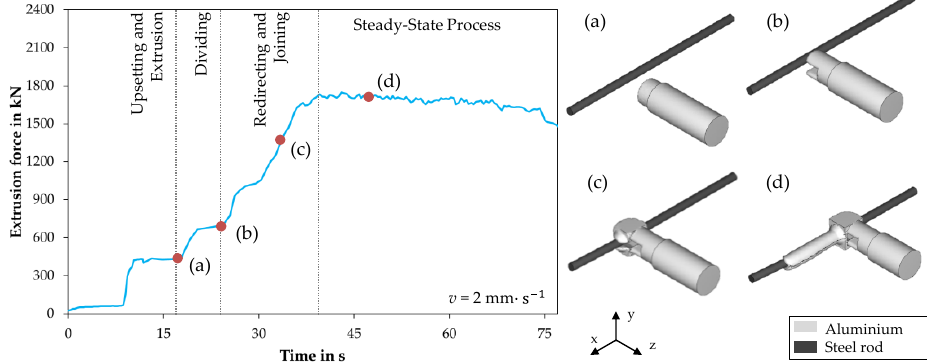
Figure 6. Extrusion force-time diagram with highlighted process steps and numerical modelling of the material flow during the co-extrusion of aluminum and steel: ( a ) upsetting and extrusion; ( b ) dividing into two material streams; ( c ) filling of the tool, redirection and joining; ( d ) forming and steady material flow.